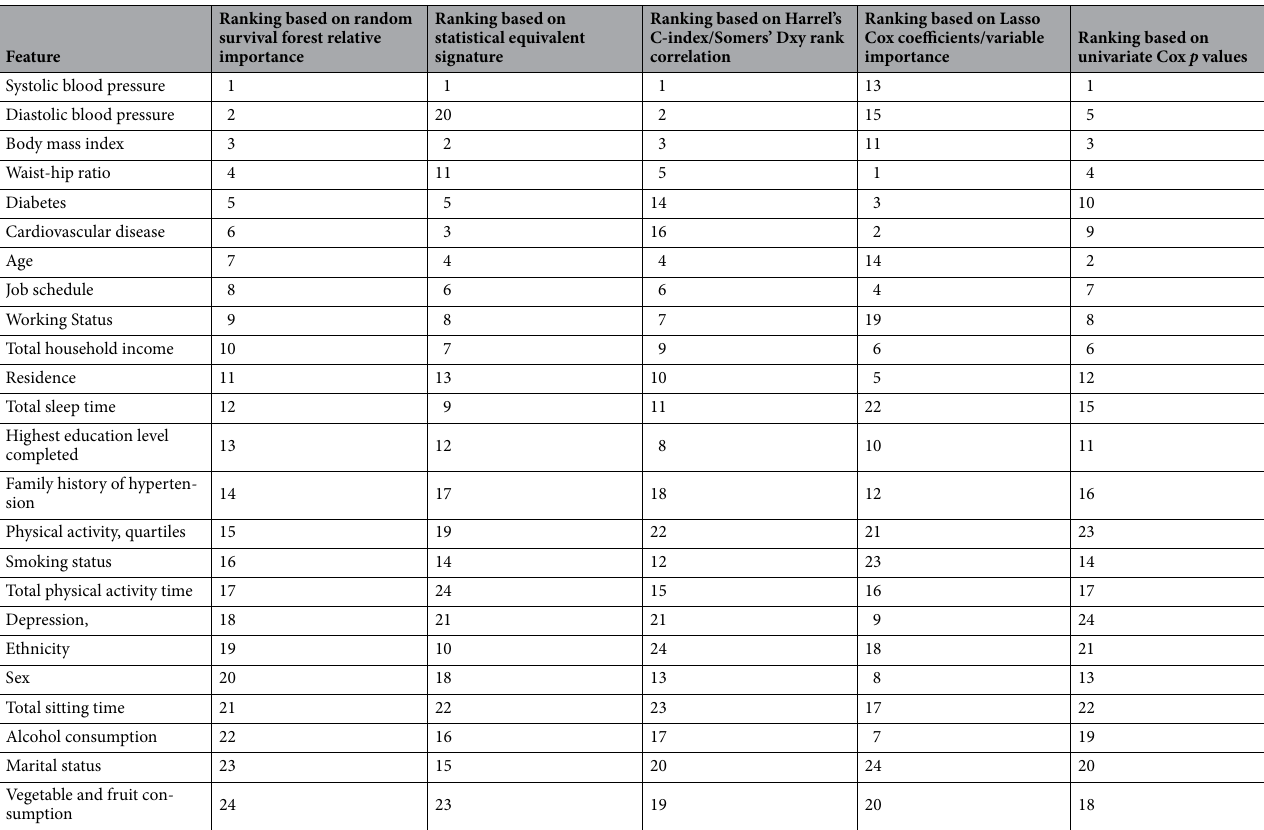
Table 2. Feature’s ranked based on five different